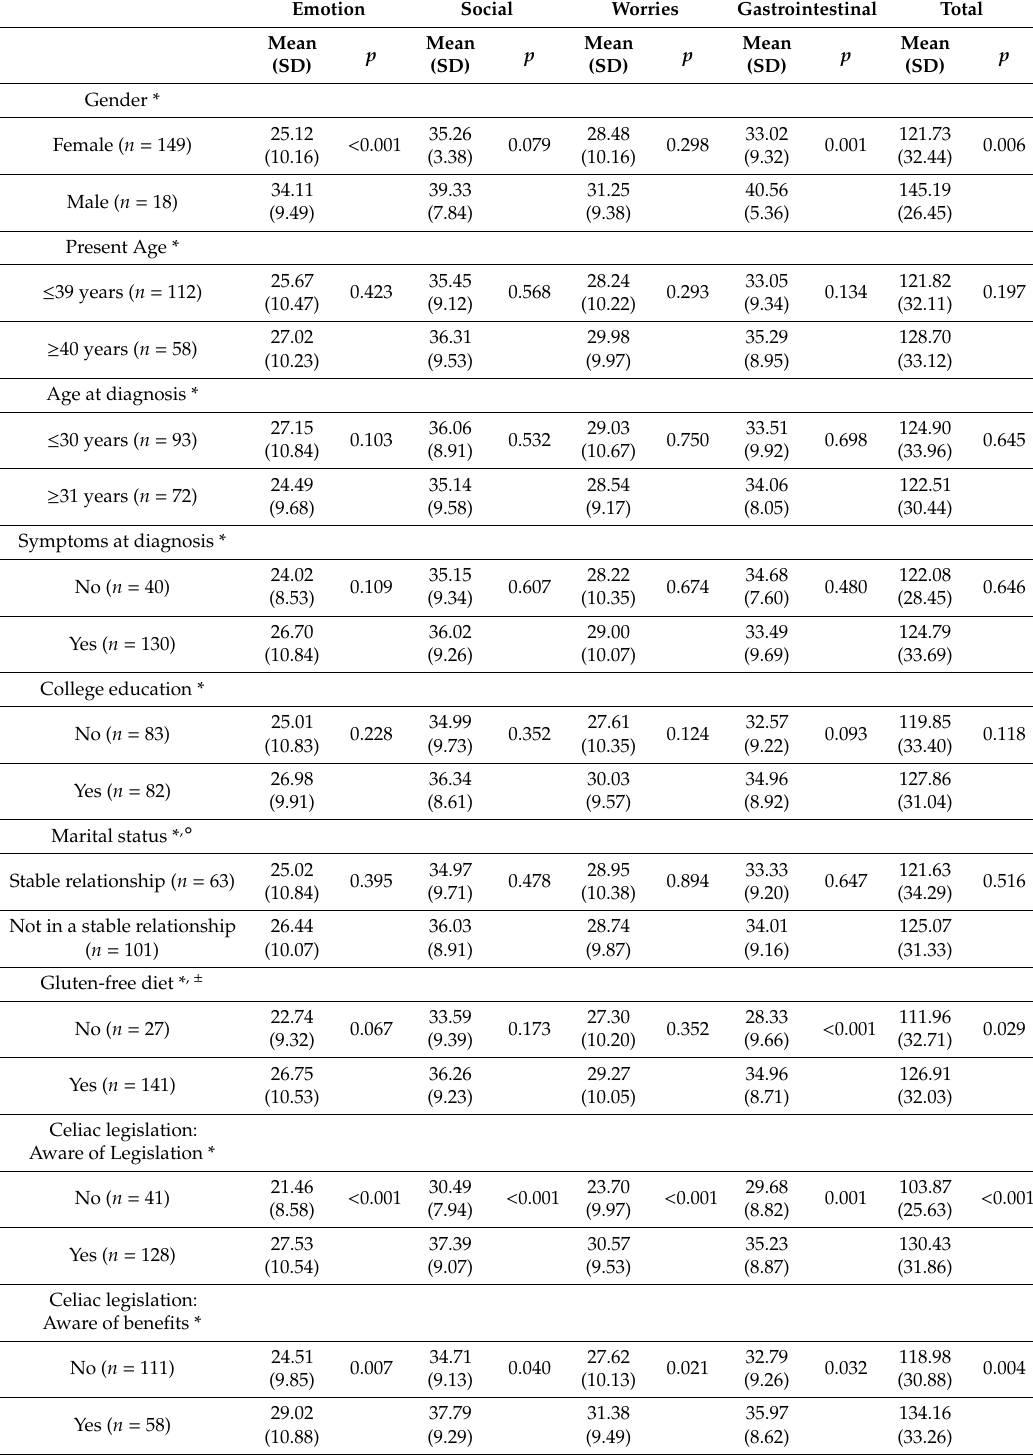
Table 2. Sub-scores of the CD-QoL scale subcategorized by the characteristics of participants. Emotion Social Worries